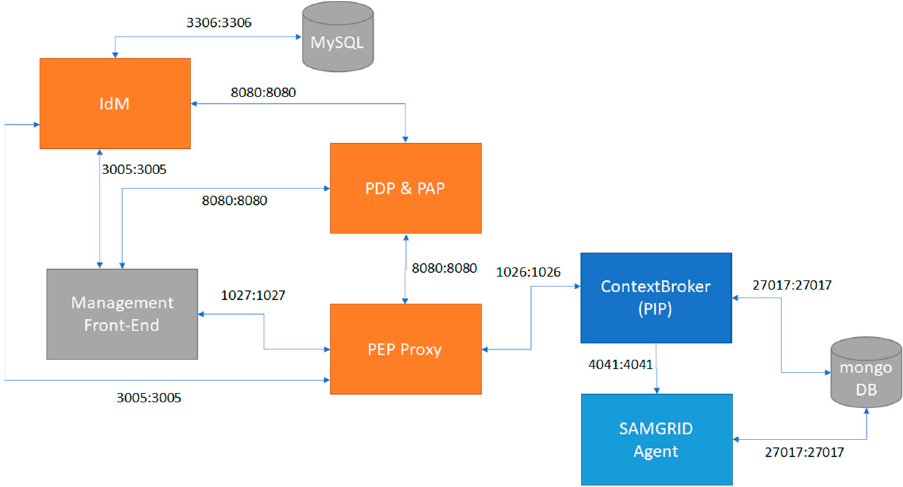
Figure 1. Illustration of participants in the authorization component of SAMGRID.